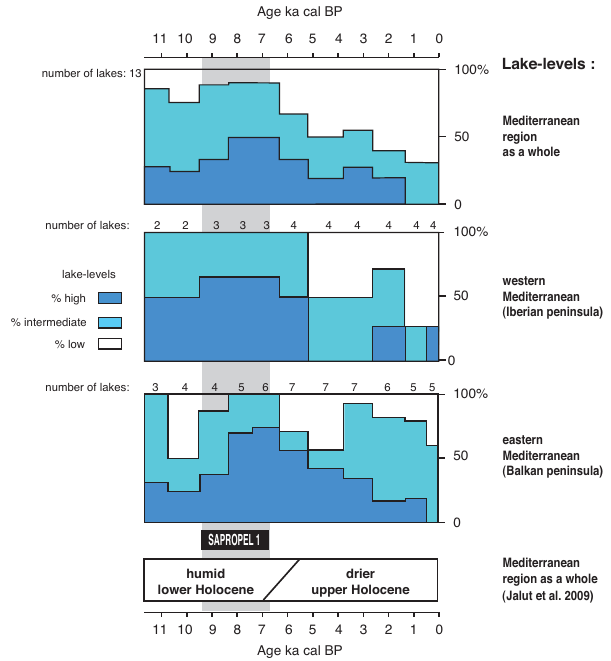
Figure 1 Fig. 1. Holocene changes in lake-level status and humidity in the Mediterranean as reconstructed by Harrison and Digerfeldt (1993) (upper three diagrams) and Jalut et al. (2009). The date of Sapro- pel 1 deposition in the Mediterranean was taken from Mercone et al. (2000). LC: Lake Cerin; LSP: Lake Saint-Point. TR: Tunisian